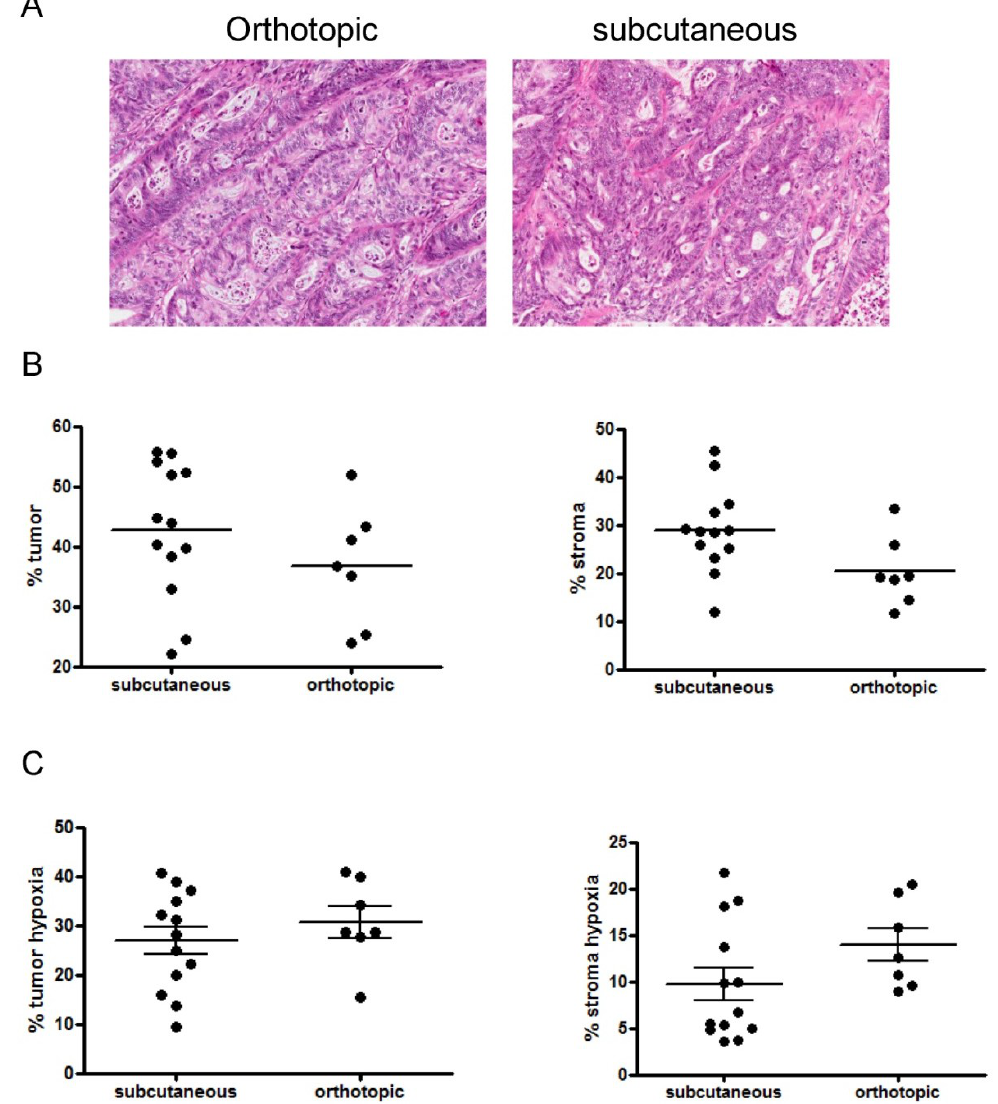
Figure A1. The patient-derived xenografts display similar characteristics at both the subcutaneous and orthotopic implantation site. Xenografts maintain stable ( A ) morphology, ( B ) tumor and stroma content and ( C ) hypoxia levels at both the subcutaneous and orthotopic implantation site as displayed on the example of